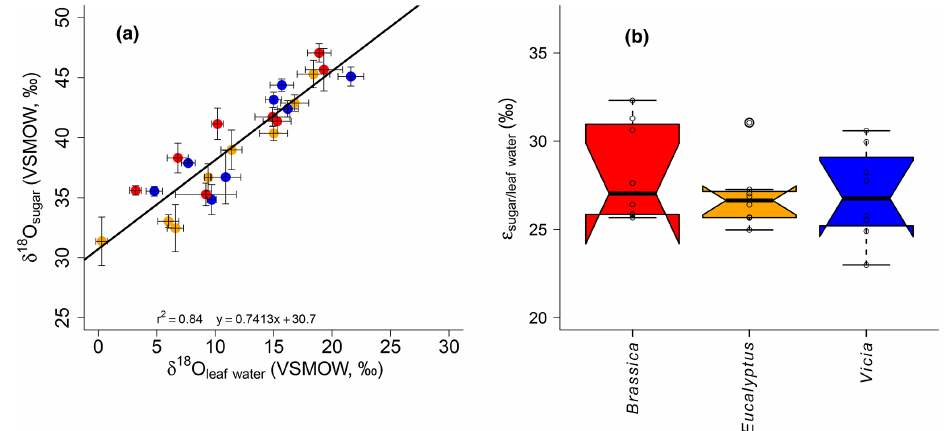
Figure 6. (a) Scatterplot depicting the relationship between δ 18 O sugar vs. δ 18 O leaf water . Error bars of the δ values represent standard deviation of repeated measurements (see Sect. 2.2 and Mayr, 2002). (b) Boxplot comprising the plant-specific fractionation ε sugar / leaf water according to Eq. (11), showing median (thick black line) and interquartile range (IQR) with upper (75%) and lower (25%) quartiles and lower and upper whiskers, which are restricted to 1.5 · IQR. Outside the 1.5 · IQR space, the data points are marked with a dot. The notches √ n by convention and give a 95% confidence interval for the difference of two medians (McGill et al., 1978). are extended to ± 1 . 58 · IQR / Brassica oleracea, Eucalyptus globulus and Vicia faba samples are shown in red, orange and blue,